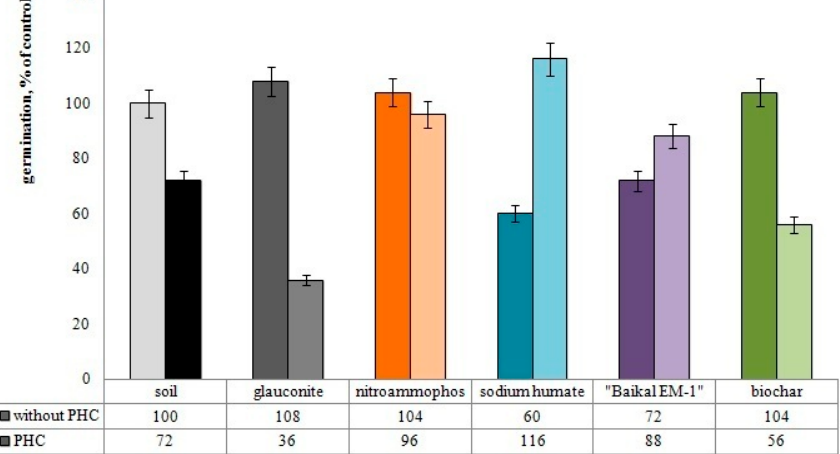
Figure 11. Change in the germination of radish seeds in non-contaminated and petroleum hydrocarbon-contaminated Haplic Chernozem Calcic soil after adding bioremediators of different natures, % of control. Note: PHC, petroleum hydrocarbon.